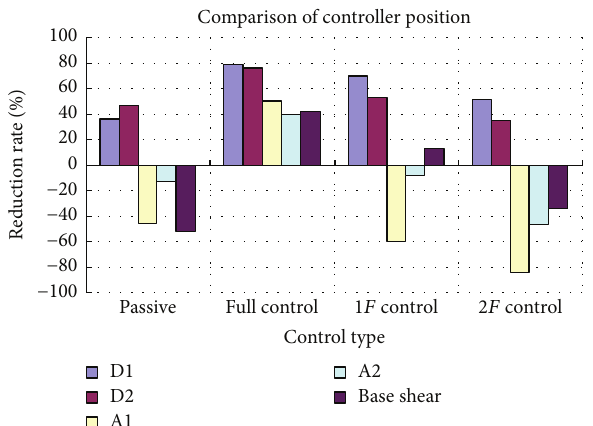
Figure 18: Comparison of shock absorption ratios of the test structure with different control types under excitation of the El Centro earthquake.